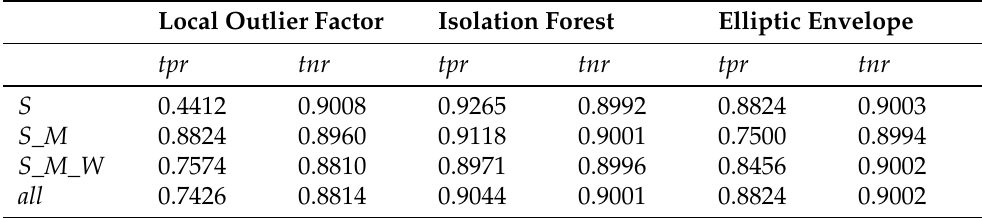
Table 11. Extended CreditCard dataset outlier detection based fraud